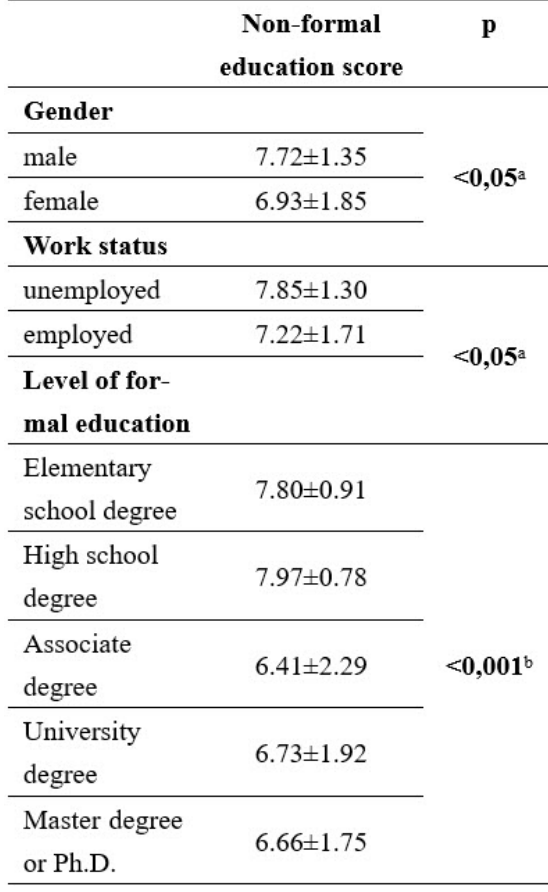
Table 4. Non-formal education score depending on socio-demographic variables